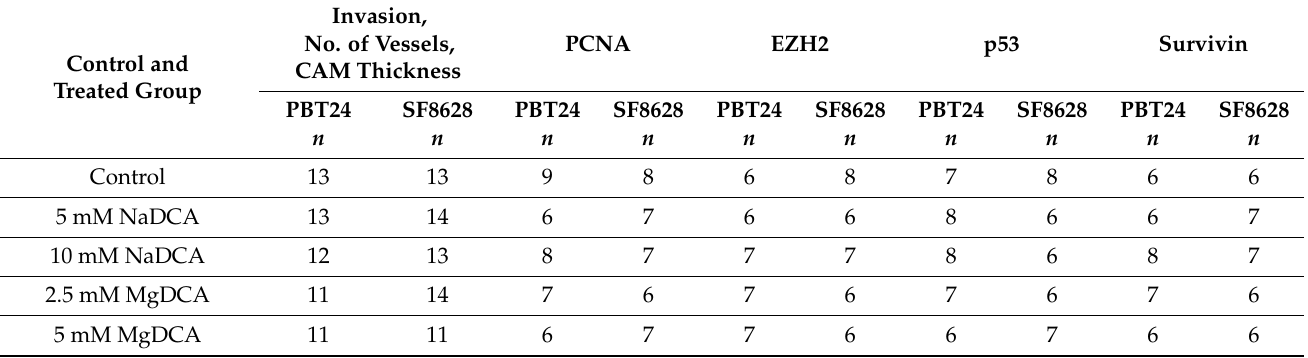
Table 8. Control and treated PBT24 and SF8628 tumors on CAM groups, tumor markers expression study groups, and sample